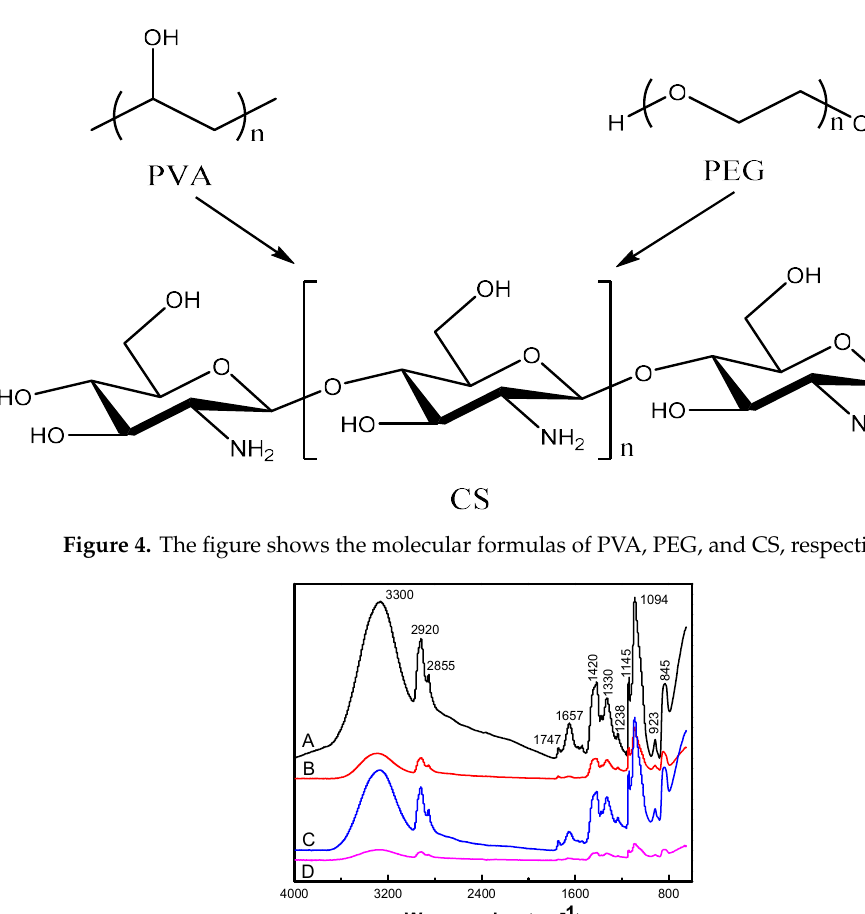
Figure 6. The cross-sectional morphology of hydrogels are ( A ) AS0, ( B ) AS25, ( C ) AS50, and ( D ) AS75; EDS (Energy Dispersive Spectrometer) element analysis of hydrogels are ( E ) AS0 and ( F ) AS75. Table 2. Analysis of the content of elements in hydrogel by EDS. Sample